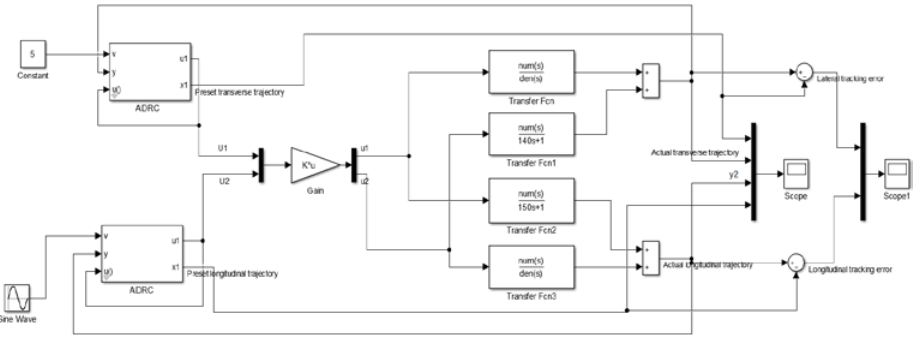
Fig. 4. ADRC decoupled control simulink